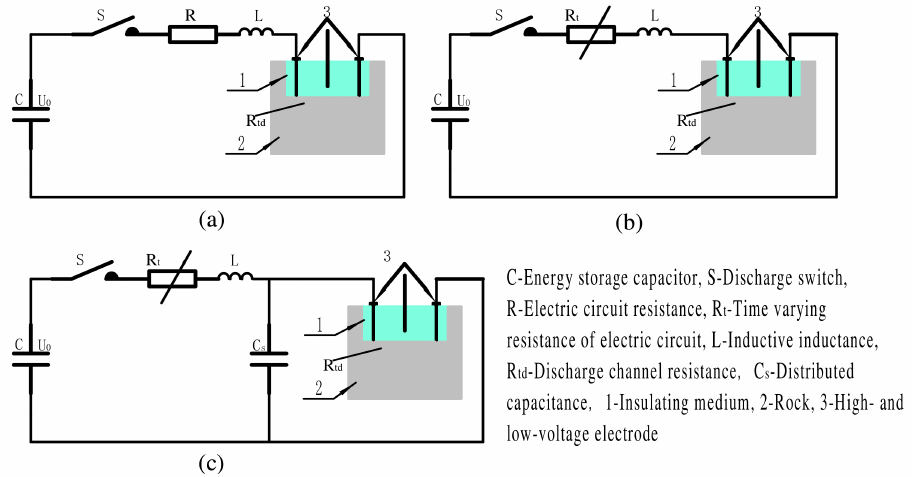
Figure 1. EPB Equivalent circuits of these three models, ( a ) RLC equivalent circuit model, ( b ) TV-RLC equivalent circuit model, and ( c ) TV-CRLC equivalent circuit